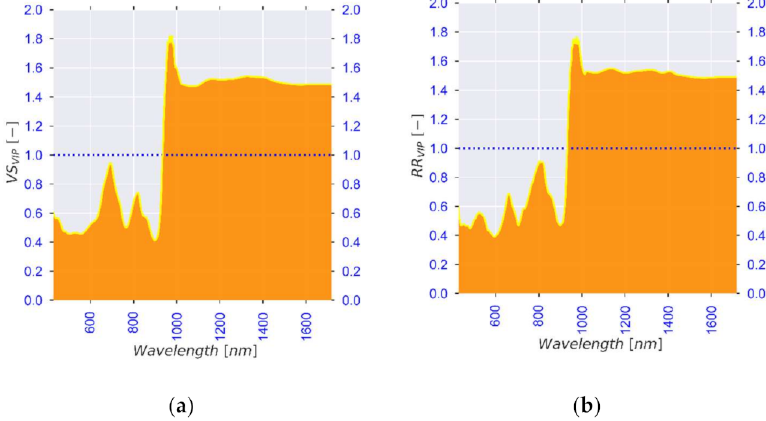
Figure 6. VIP plots for ( a ) volumetric shrinkage and ( b ) rehydration